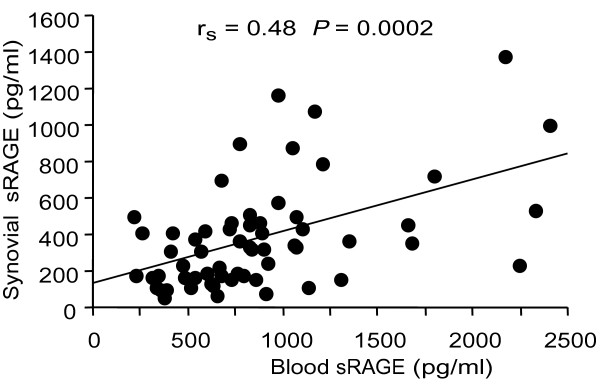
Scattergram showing an association between blood and synovial soluble receptor for advanced glycation end products (sRAGE) levels in rheumatoid arthritis patients. The Spearman rank correlation coefficient (rs) and P value are given.